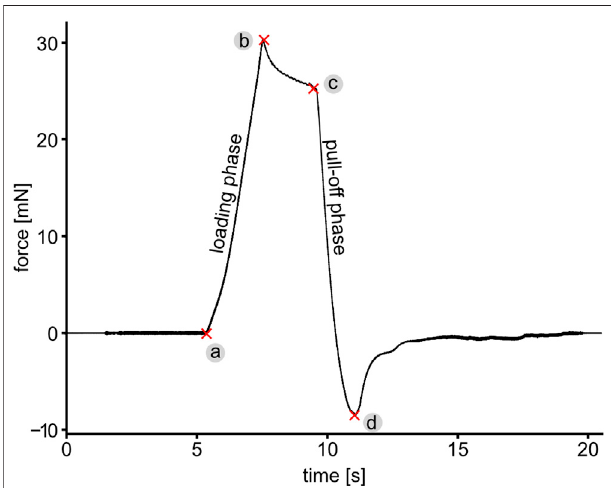
FIGURE 3 | A representative force-time curve showing different phases of the force measurement, while pushing and pulling the pollinarium with a glass rod. (a) Contact formation, (a – b) loading phase, (b – c) time in contact showing viscoelastic relaxation similar to pressure sensitive adhesives and (c – d and further until the end of curve) pull-off phase. The maximum pushing and pulling force are denoted as points (b) and (d), respectively. The maximum pulling force is hereinafter referred to as the pull-off force, which characterizes either the detachment force of the viscidium from the glass rod (in the case the pollinarium cannot be removed from the fl ower) or the force required to pull the whole pollinarium out of the fl